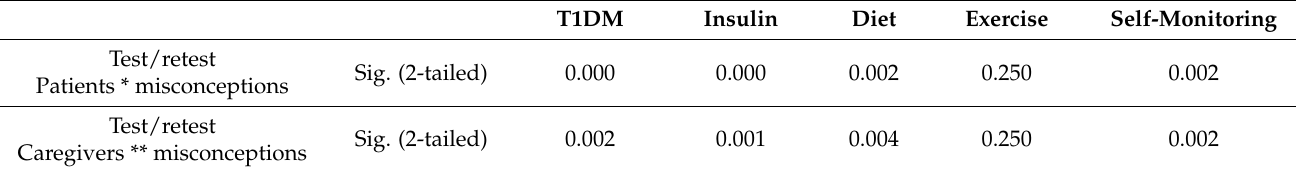
Table 3. McNemar’s test for differences between binary variables test/retest contrasts.